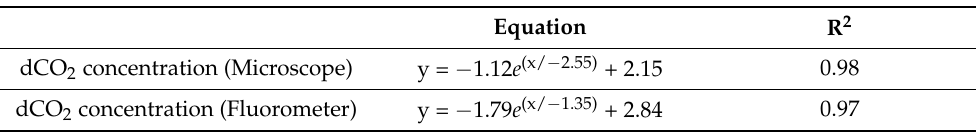
Table 5. Exponential equations for luminescence intensity changes in dCO 2 concentration for micro- scope and fluorometer